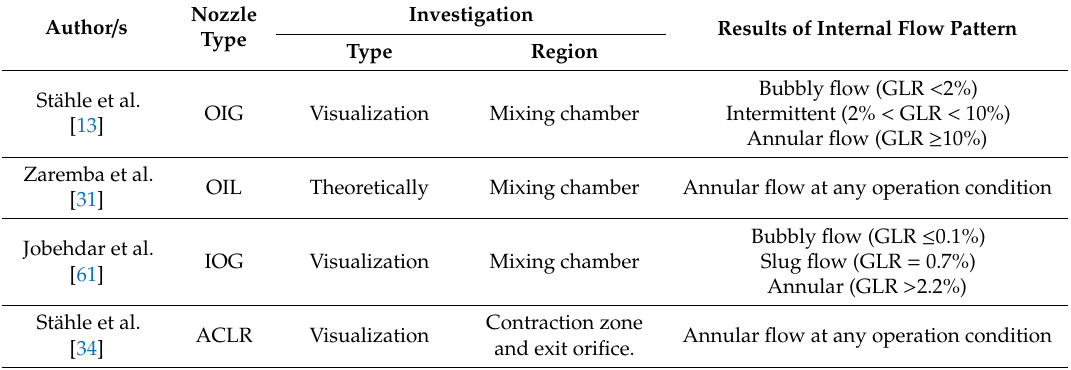
Table 4. Summary of the internal flow pattern of the tested IMTF nozzles from the